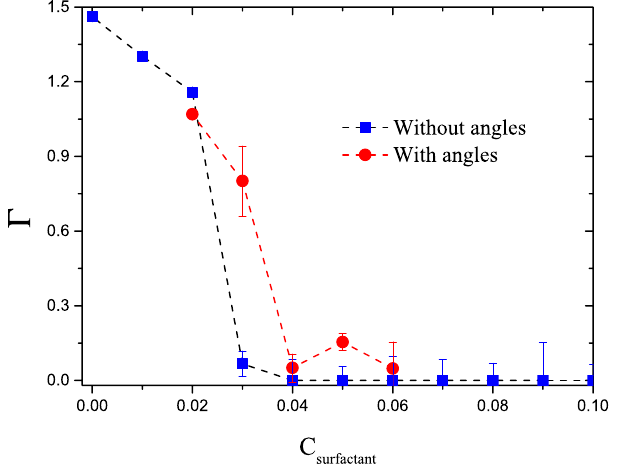
Figure 8. Heptane desorption isotherms with, and without bond angle interactions using long, nonionic surfactants. Solid blue squares are those for the case when the monomers in the heptane molecule are joined by freely rotating springs (taken from Fig. 5(A)), while the red circles represent the case when there is a three-body harmonic potential between bonds along the heptane molecule.